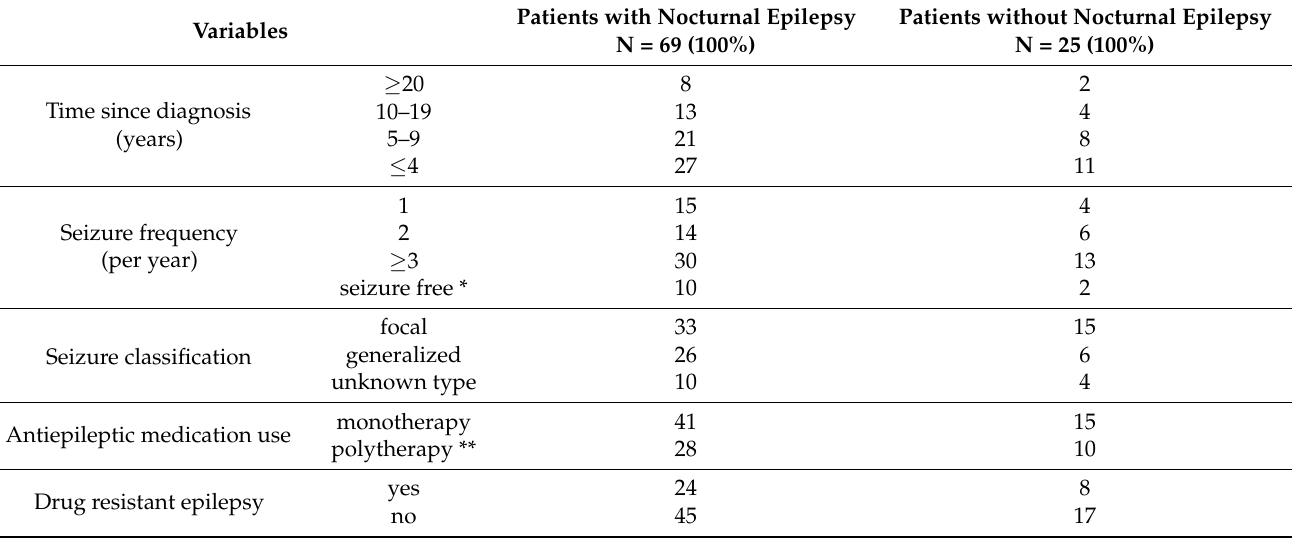
Table 2. Clinical characteristics of